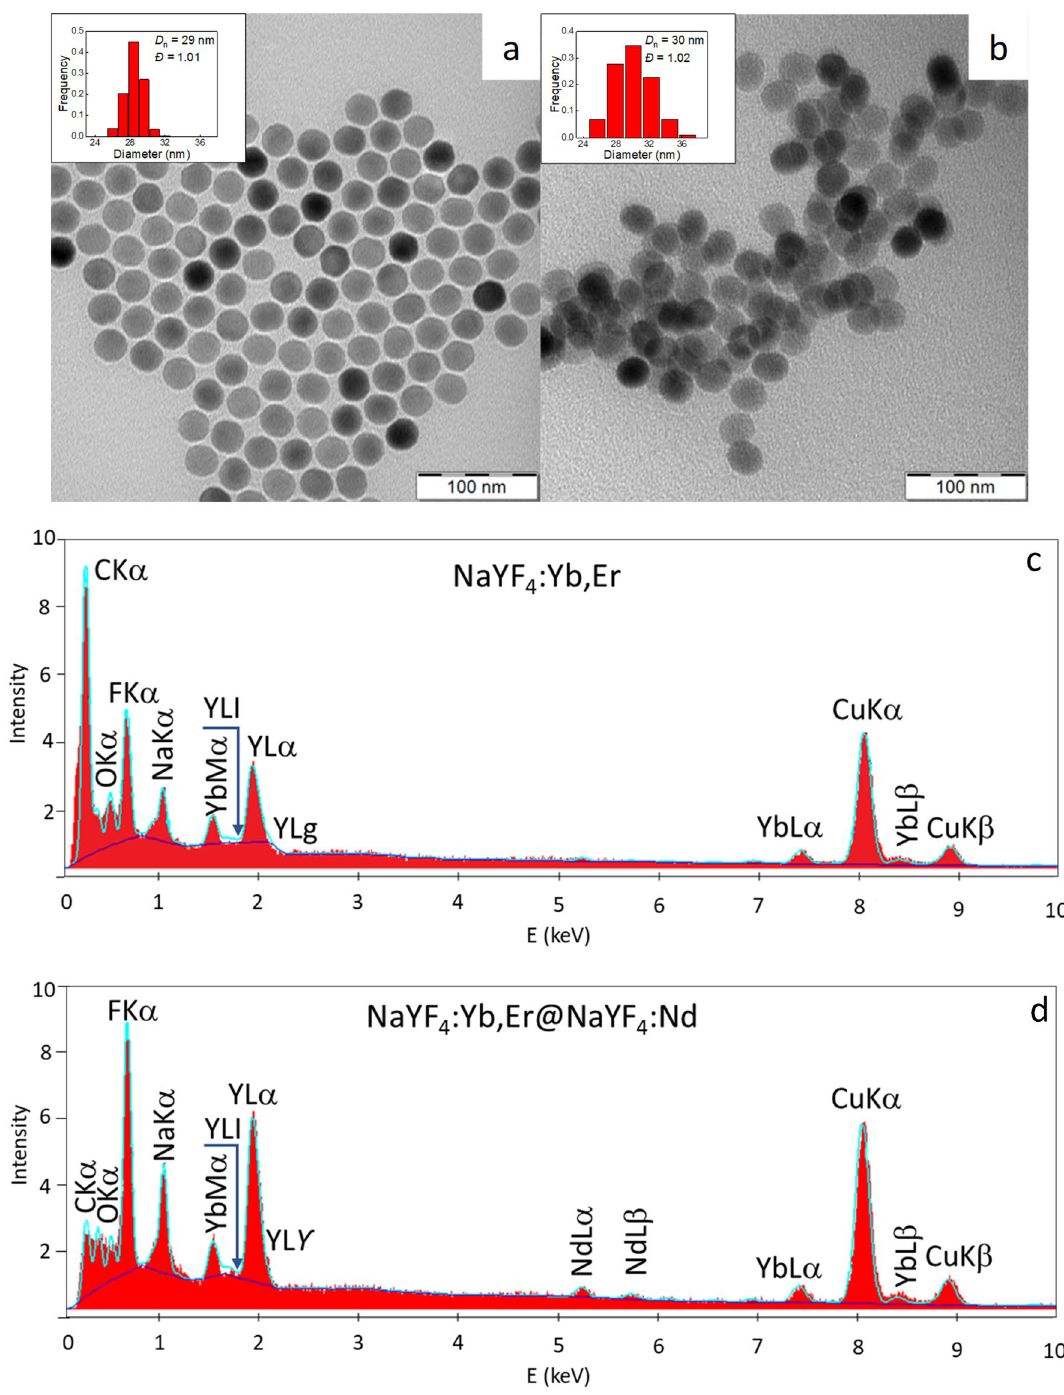
Figure 4. TEM micrographs and TEM/EDX analysis of ( a , c ) C-UCNP and ( b , d ) CS-UCNP. C-UCNP— contrast, the negative surface charge (− 9 mV) on Ale-P(DMA-AMPS)-DY-615-modified particles was likely caused by the presence of sulfo groups. The presence of DY-615 dye on Ale-P(DMA-AEC)-DY-615, Ale-PDMA- DY-615, and Ale-P(DMA-AMPS)-DY-615-coated CS-UCNPs was proved by the appearance of absorption peak at 617 nm in the UV–Vis spectra (Fig. S6a). The functionalization of particles with Ner-PEG and PDMA-based (co)polymers was also confirmed by the photoluminescence spectra of CS-UCNP (Figs. 5b and S6b). While the free DY-615 emitted light at 641 nm, after the excitation of Ale-PDMA-DY-615-, Ale-P(DMA-AEC)-DY-615-, and Ale-P(DMA-AMPS)-DY-615-coated CS-UCNP at 621 nm, the intense emission at 637 nm was assigned to DY-615 (Fig. S6b). The shift of emission peak (by 3 nm) from that of free DY-615 was ascribed to the conjugation